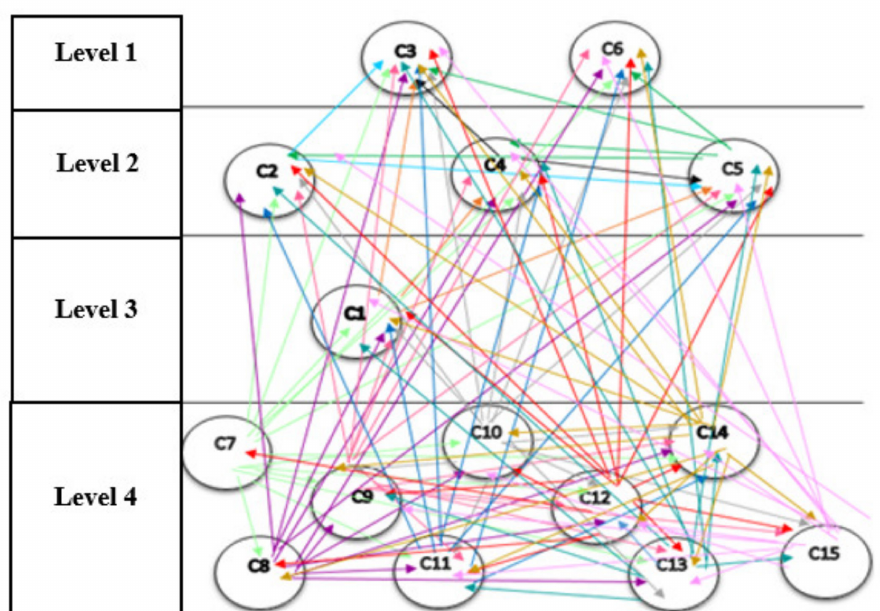
Figure 9. Output of Dematel technique and structural interpretive modelling. C1: